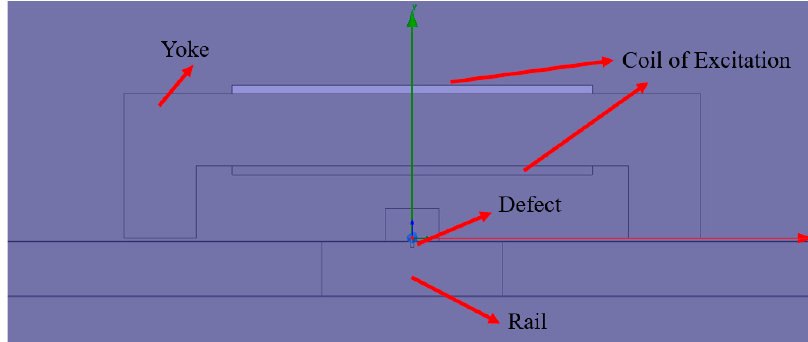
Figure 5. Magnetic flux leakage simulation model.